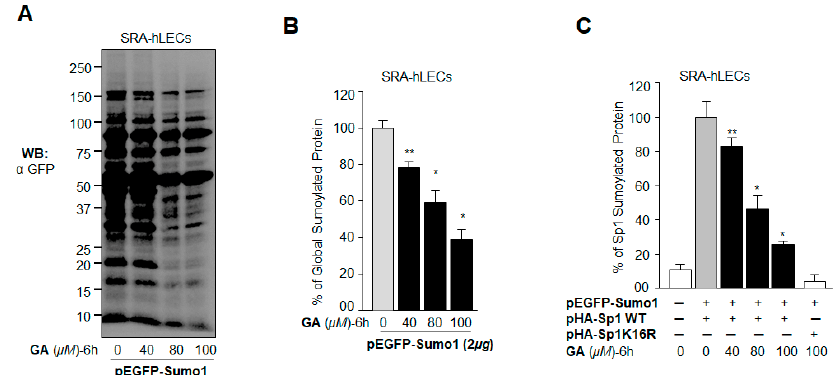
Figure 6. GA blocked aberrant Sumoylation signaling in SRA-hLECs. ( A ) LECs were transfected with pEGFP-Sumo1 and then treated with various concentrations of GA (40–100 µ M) for 6 h. Equal amounts of extracted protein containing N -ethylmaleimide (NEM) and MG132 were immunoblotted with an anti-GFP antibody. ( B ) The same lysate (as above) was used to quantify global Sumoylation protein. Equal amounts of protein were loaded onto the GFP antibody-coated ELISA plate-well. Following incubation with a Sumo1 antibody, the Sumoylated protein was quantified after the addition of color developing reagent as described in Materials and Methods. ( C ) Inhibition of Sp1 Sumoylation by GA in vivo. LECs transfected with the indicated combinations of pEGFP-Sumo1, Sp1 or a Sumoylation-deficient mutant (Sp1K16R) were treated with various concentrations of GA (40–100 µ M) for 6 h. Equal amounts of cell extract were used to quantify exogenous Sp1 Sumoylation using an anti-human Influenza virus hemagglutinin (HA) antibody. The data represent mean ± SD from three independent experiments (** p < 0.05; * p < 0.001).